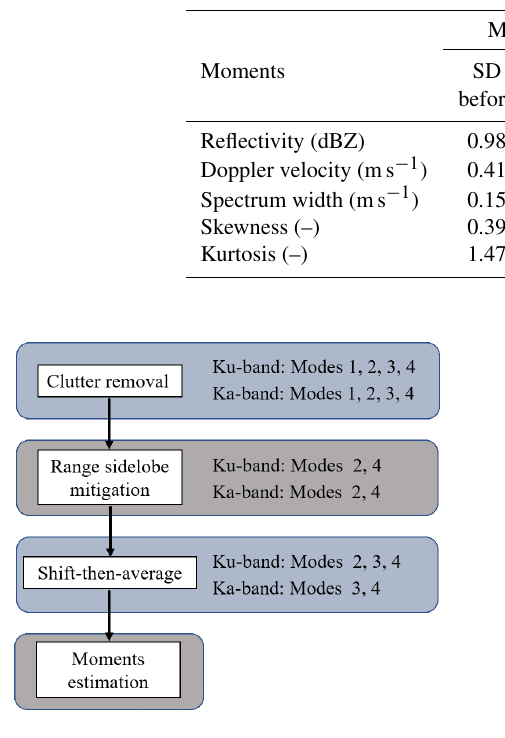
Figure 14. Procedures for generating estimates of spectral mo- ments.